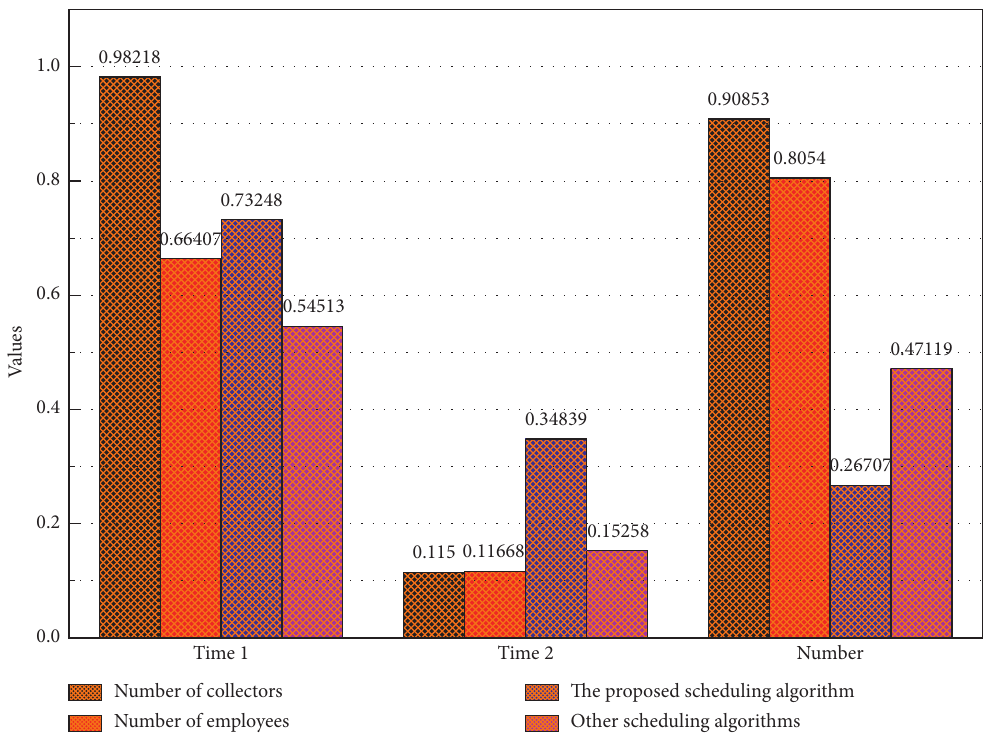
Figure 3: The trend of the average processing time of two scheduling algorithms for small areas with low event frequency.